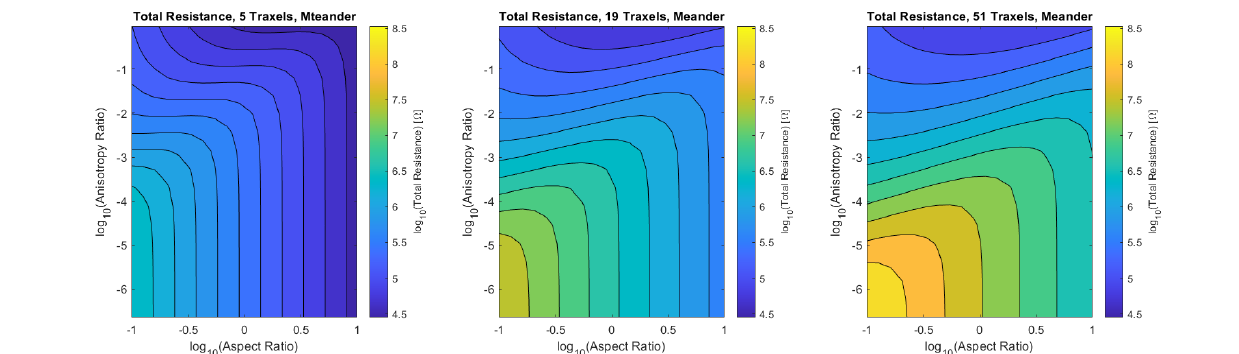
Figure 26. The total resistance for the open-ended model as a function of aspect ratio and anisotropy ratio for 5, 19, and 51 traxels. The resistance is approximately the same for the different numbers of traxels.